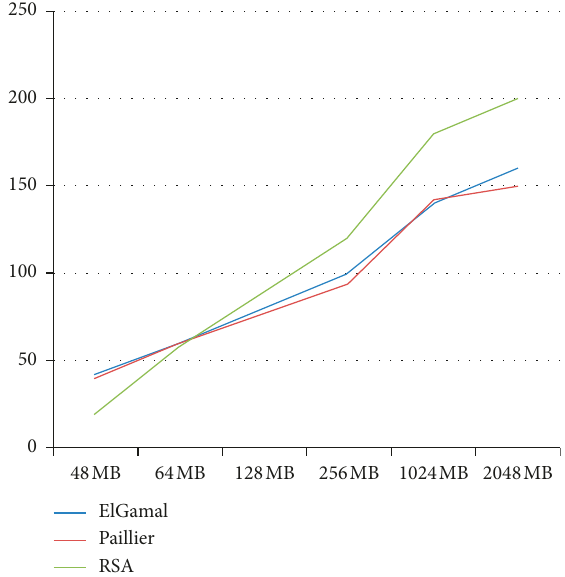
Figure 7: Percentage of CPU usage for different public key al- gorithms like ElGamal, Paillier, and RSA.